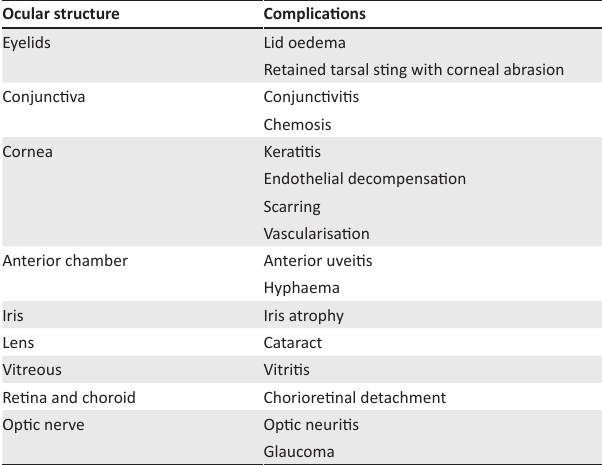
TABLE 1: Ocular complications of a bee sting. Ocular